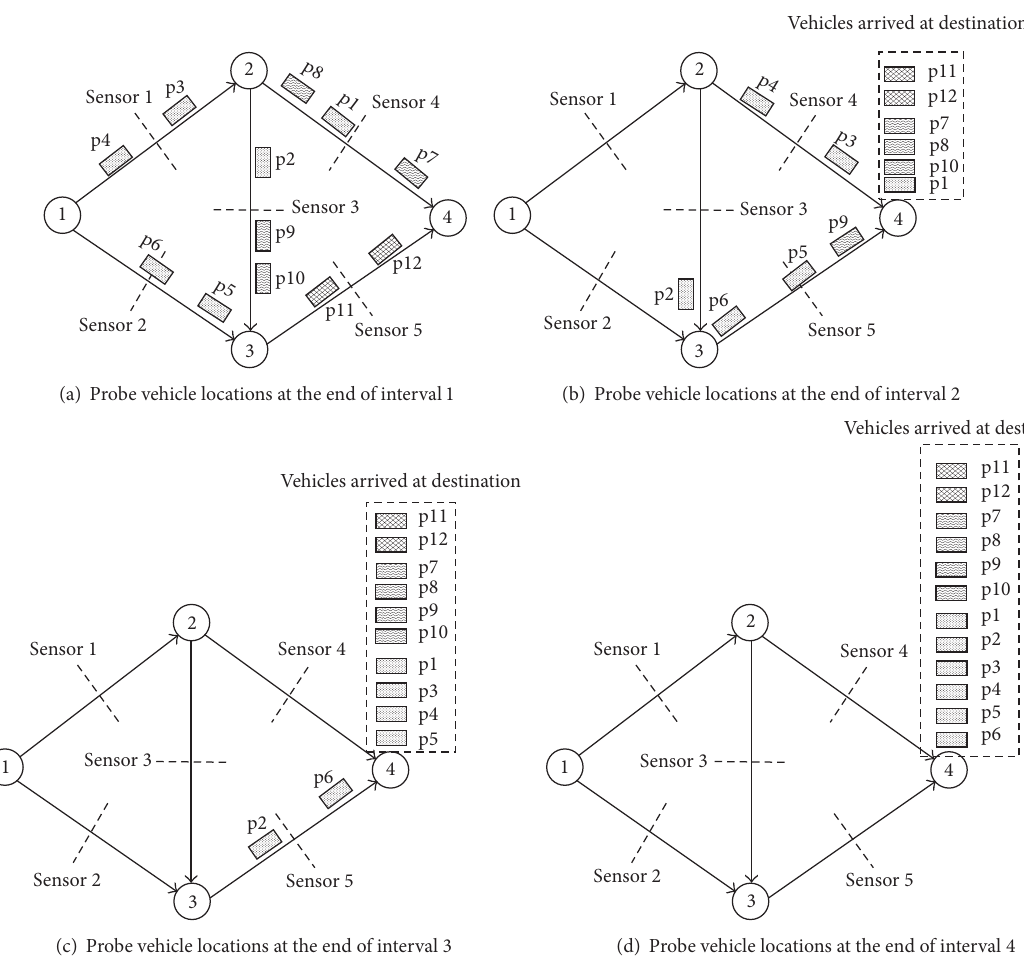
Figure 2: Illustration of probe vehicle locations captured at the end of each